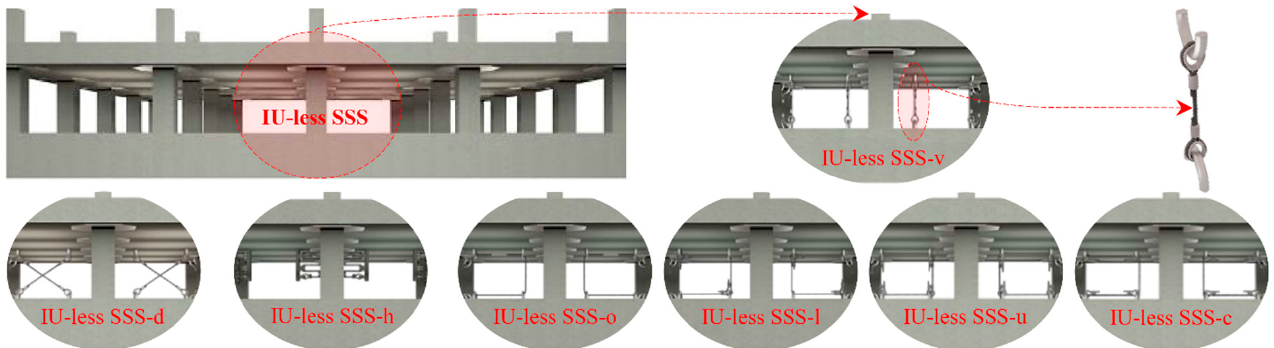
Figure 4. IUs of SSS: ( a ) the IU of SSS ‐ v; ( b ) a cross section passing through a diagonal plane of the IU of SSS ‐ v; ( c ) a disassembled view of the IU of SSS ‐ v; ( d ) the IU of SSS ‐ d; ( e ) the IU of SSS ‐ h; ( f ) the IU of SSS ‐ o; ( g ) the IU of SSS ‐ l; ( h ) the IU of SSS ‐ u; ( i ) the IU of SSS ‐ c.